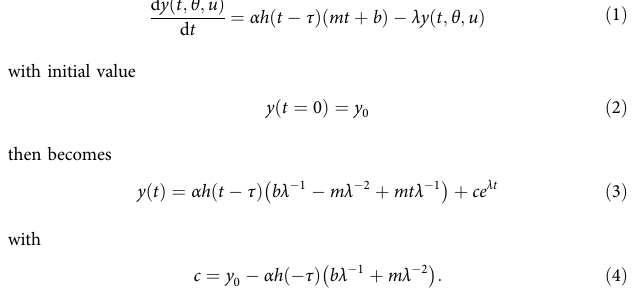
metabolic process ” (GO:0019318), “ gluconeogenesis ” (GO:0006094), “ hexose biosynthetic process ” (GO:0019319). Proteins (34) assigned the following GO terms are plotted in Supplementary Figure 5b: “ mitotic spindle organization ” (GO:0007052), “ mitotic cell cycle process ” (GO:1903047), “ cell cycle process ” (GO:0022402), “ microtubule cytoskeleton organization involved in mitosis ” (GO:1902850), “ mitotic centrosome separation ”